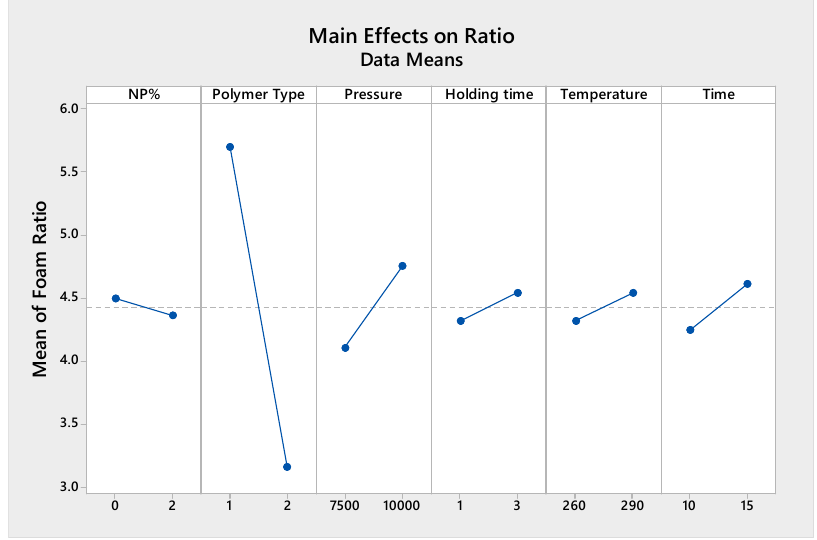
Figure 15. Effect of all of the parameters on the foaming ratio. The process parameters were expected to have the same effect on the foaming ratio and density, as increasing foaming ratios lead to a decrease in density. This is valid unless NPs are added. If the polymer contains NPs, the foaming ratio is improved, but the density does not necessarily decrease just because the NP density increases the composite